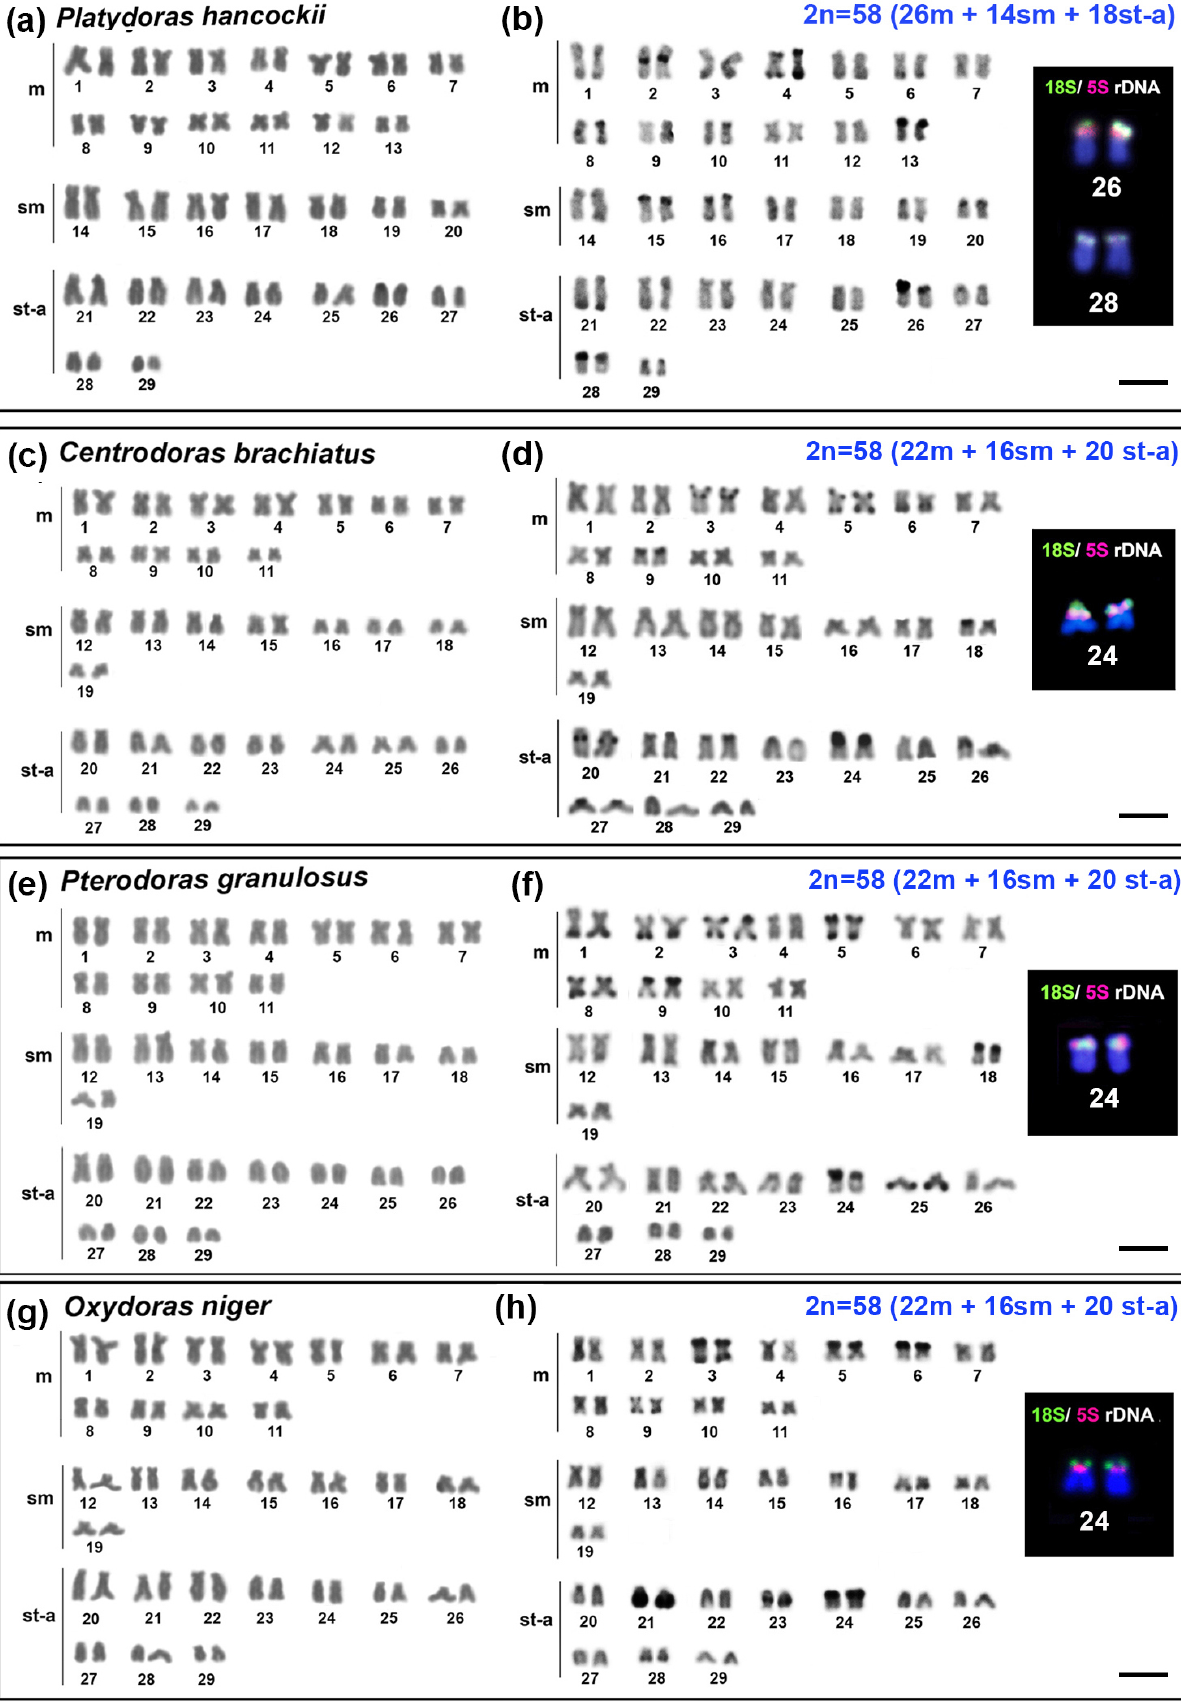
Figure 1 – Karyotypes of the Doradinae subfamily: Platydoras hancockii (a) Giemsa, (b) C-band; Centrodoras brachiatus (c) Giemsa, (d) C-band; Pterodoras granulosus (e) Giemsa, (f) C-band; Oxydoras niger (g) Giemsa, (h) C-band. The boxes contain the chromosome pairs bearing the 18S and 5S rDNA rDNA sites. The scale bar corresponds at 10